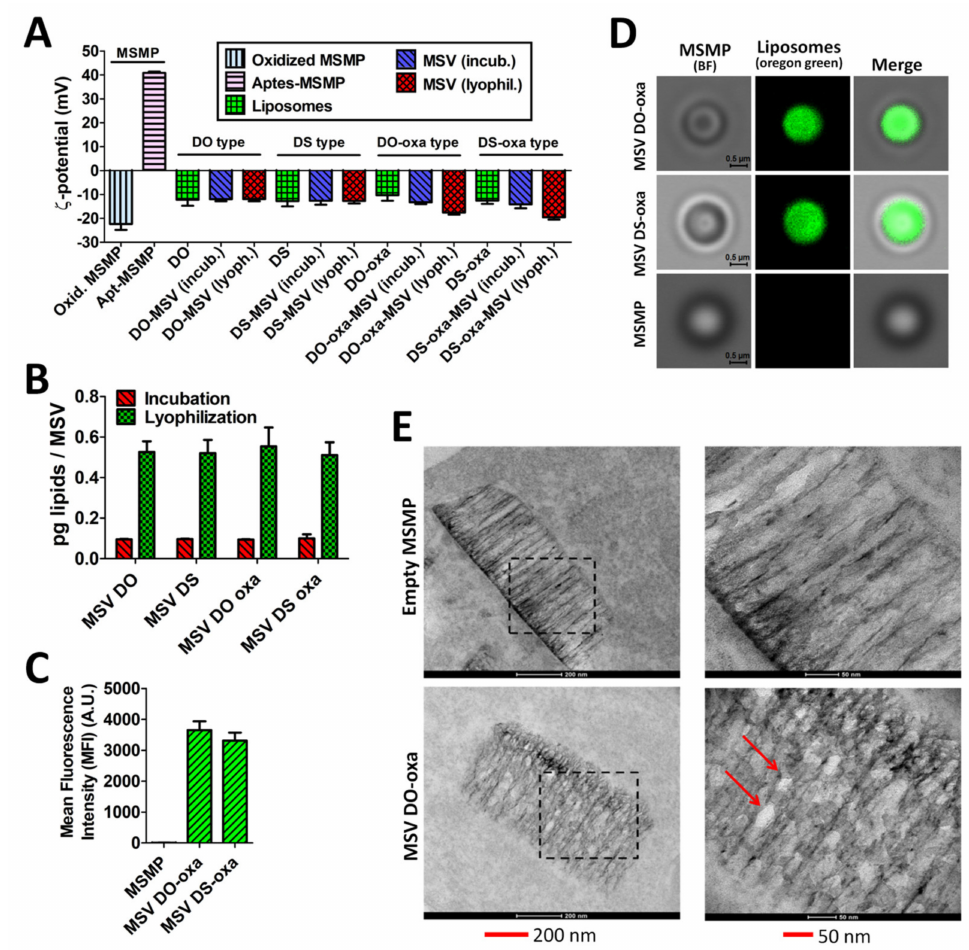
Figure 6. MSV assembly. ( A ) ζ -potential analysis of the empty MSMPs, selected liposomes and assembled MSVs; ( B ) amount of fluorescent liposomes loaded into the MSMP and measured by spectrofluorometer; ( C ) relative levels of mean fluorescence intensity (MFI) of liposomes loaded into the MSMP (i.e., MSV assembly) measured by cytofluorimetry (see also Figure S2); ( D ) qualitative analysis of MSV assembly by confocal microscopy; ( E ) TEM micrographs of the MSV. An empty MSMP and MSV DO-oxa are showed. Experiments were performed in three independent replicates. Error bars represent standard deviations. Statistical significance was calculated by one-way two-tailed t -test. Abbreviations: incub.—incubation; lyoph.—lyophilization; incub. and lyoph. refer to two methods for MSV assembly (see Materials and Methods section); A.U.—arbitrary